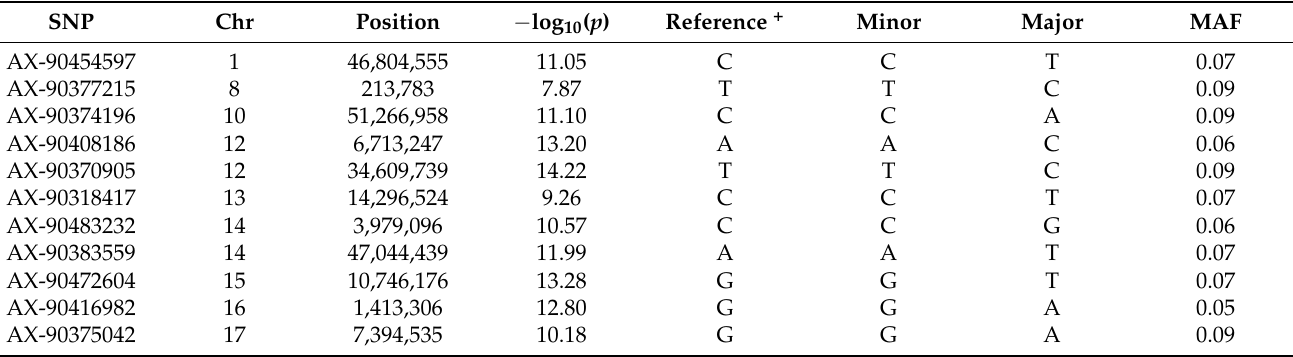
Table 4. Significant SNP markers related to 100SW in the merged